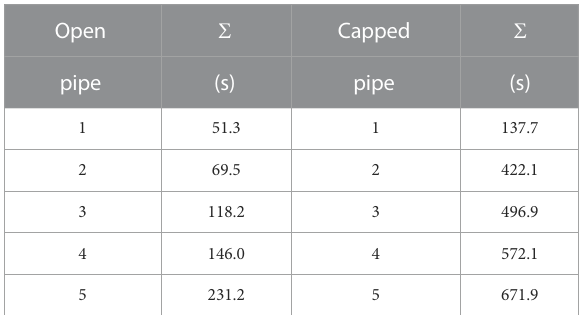
TABLE 2 Bikerman ’ s unit of